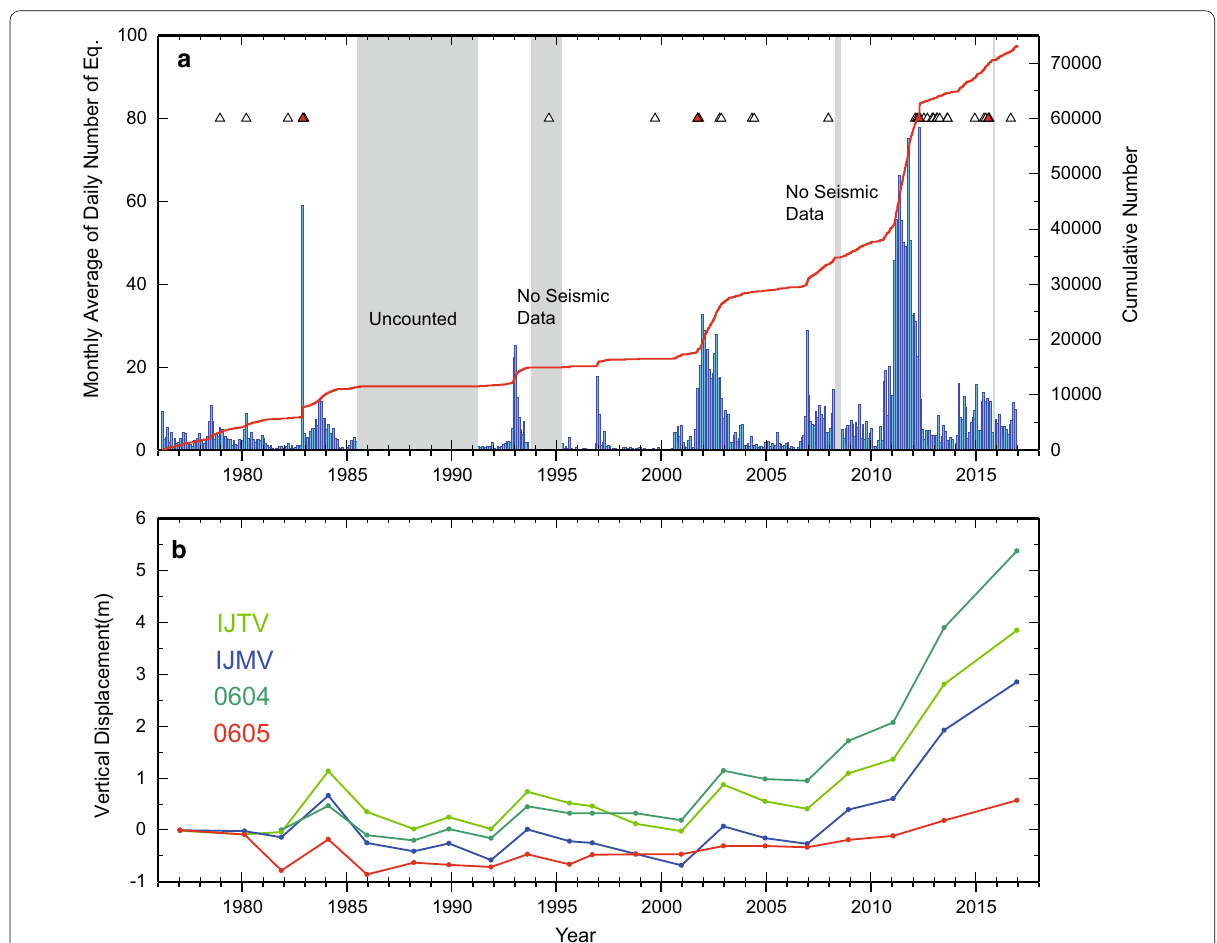
Fig. 2 A comparison between earthquake activity and vertical movement of Ioto after 1977. a Monthly average of daily number of earthquakes counted at Motoyama. The numbers are counted at seismic stations of Japan Ministry of Defense around 0604 station of GSI before 1986 and at IJMV after 1992. The red curve shows the cumulative number of earthquakes. The red triangles and white triangles denote occurrence times of phreatic eruptions with and without precursors, respectively. b Vertical movement by campaign leveling and GPS surveys after 1977 at survey points near observation points where GNSS continuous observation is carried out. In the leveling survey up until 1995, average sea level as meas- ured by the tide level gauge was taken as the reference